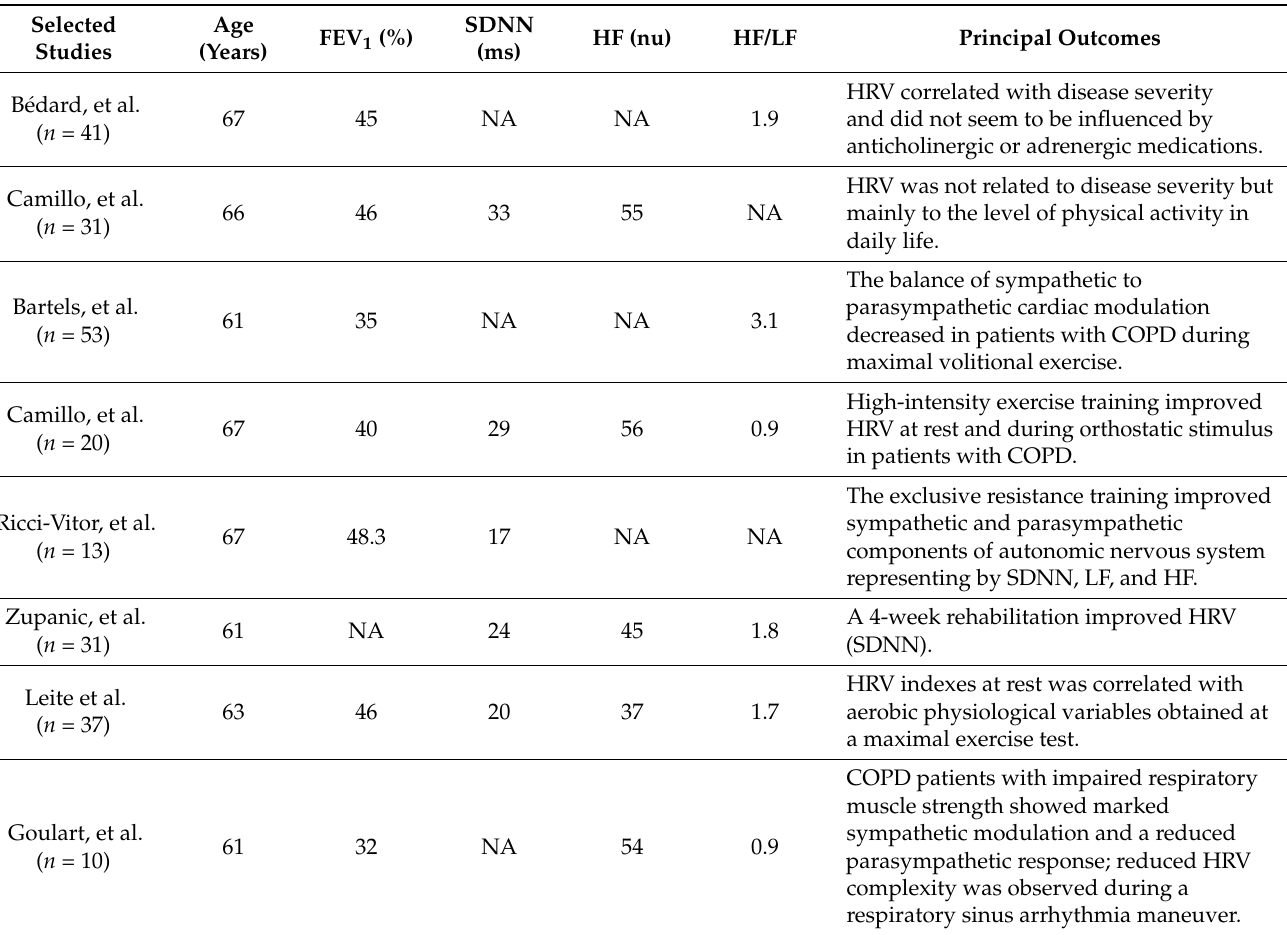
Table 4. Previous studies about HRV and patient outcomes in